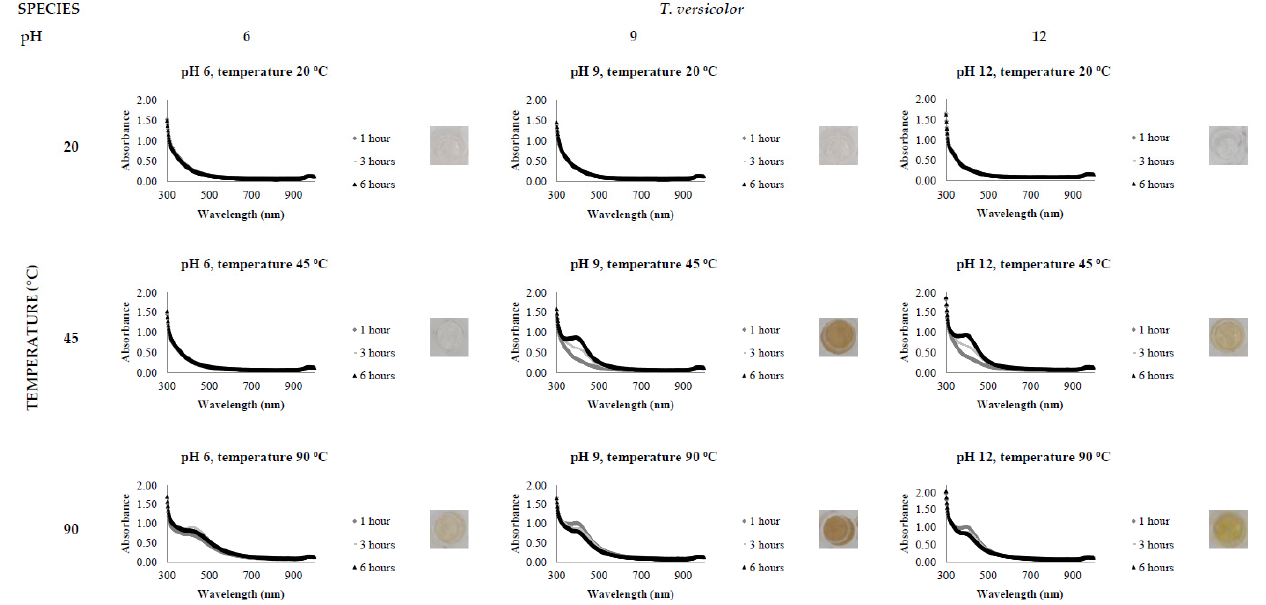
Figure 4. LSPR spectra of T. versicolor cell-free extract in the synthesis of AgNPs, by the addition of 0.5 mM AgNO 3 , varying the reaction time (1, 3 and 6 h), temperature (20, 45 and 90 °C) and pH (6, 9 and 12), through UV-Vis spectrophotometry analysis.